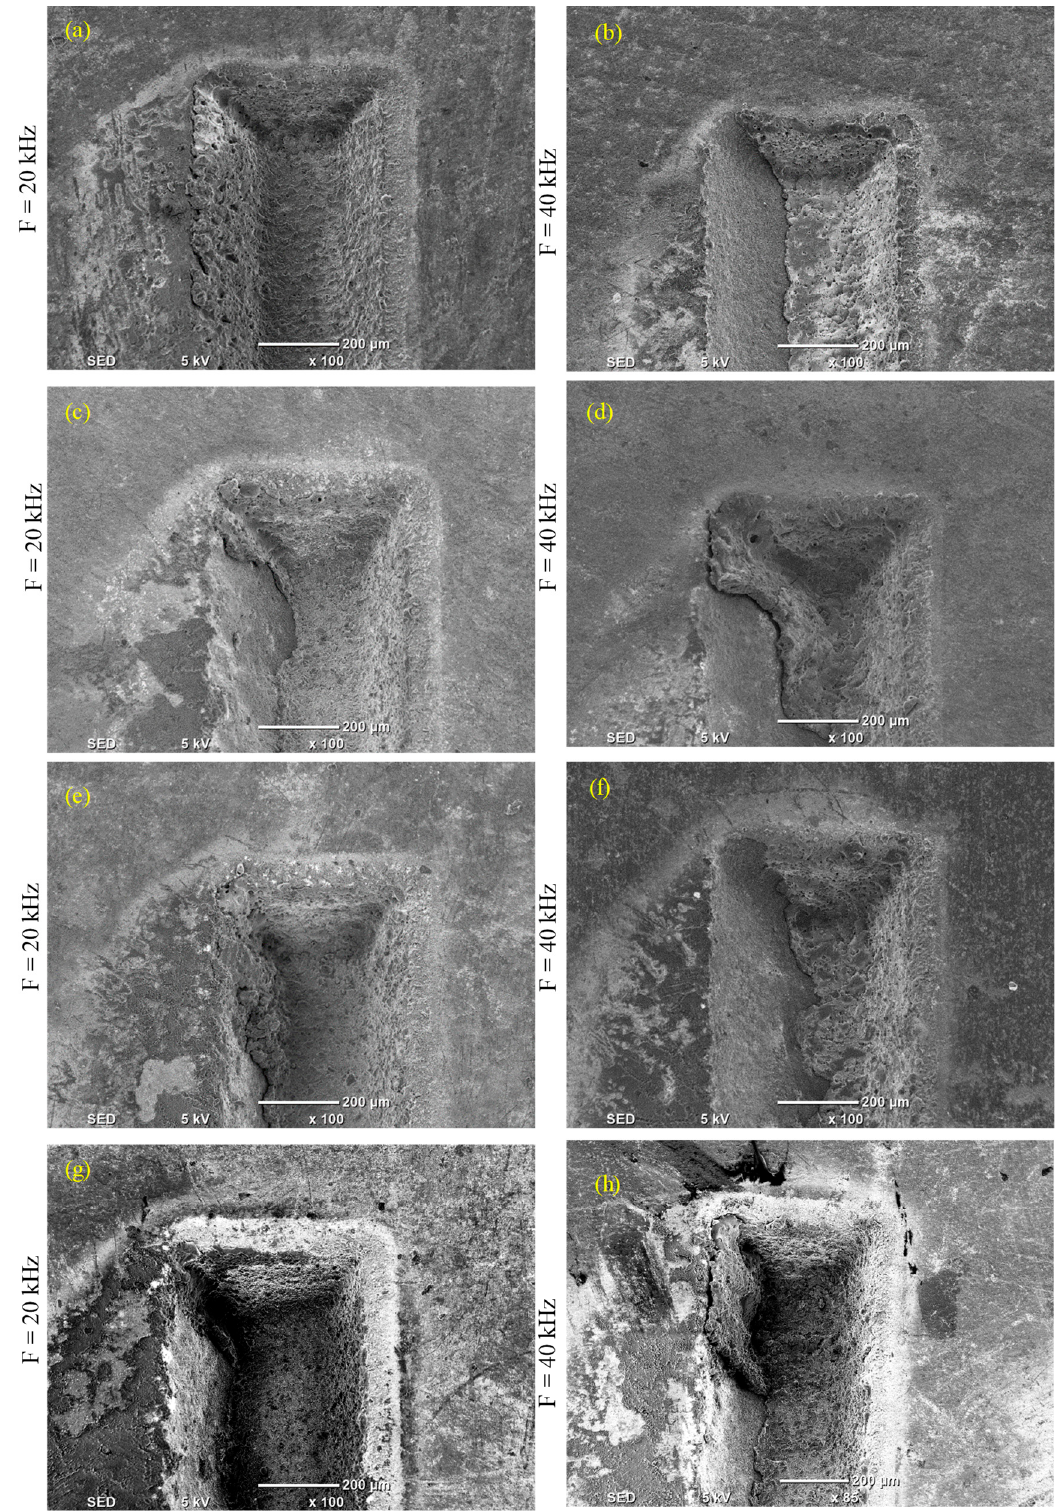
Figure 8. Surface morphologies with di ff erent GnP contents at a scanning speed of 300 mm/s. ( a , b ) 0.5 wt.% GnPs; ( c , d ) 1 wt.% GnPs; ( e , f ) 1.5 wt.% GnPs; ( g , h ) 2.5 wt.% GnPs. From the interaction e ff ect plot for MRR in Figure 9, it can be noted that the 1.2 wt.% GnP content and scanning speed of 400 mm/s obtained a higher MRR. In addition, the frequency of 30 kHz and the scanning speed of 300 mm/s also obtained a higher MRR.